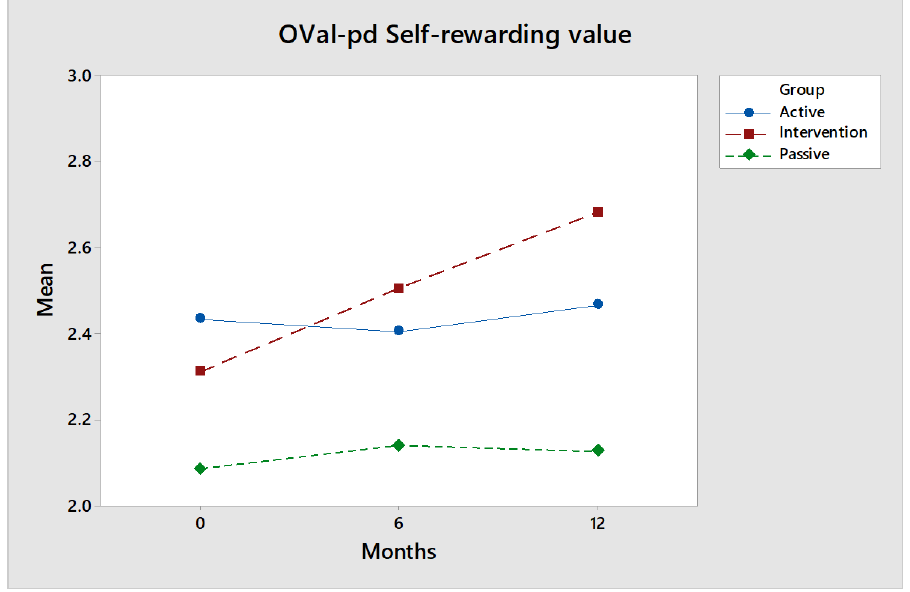
Figure 3. The Oval-pd self-rewarding value for the intervention group (red) increases over time, while the values for the control groups (green & blue) are largely the